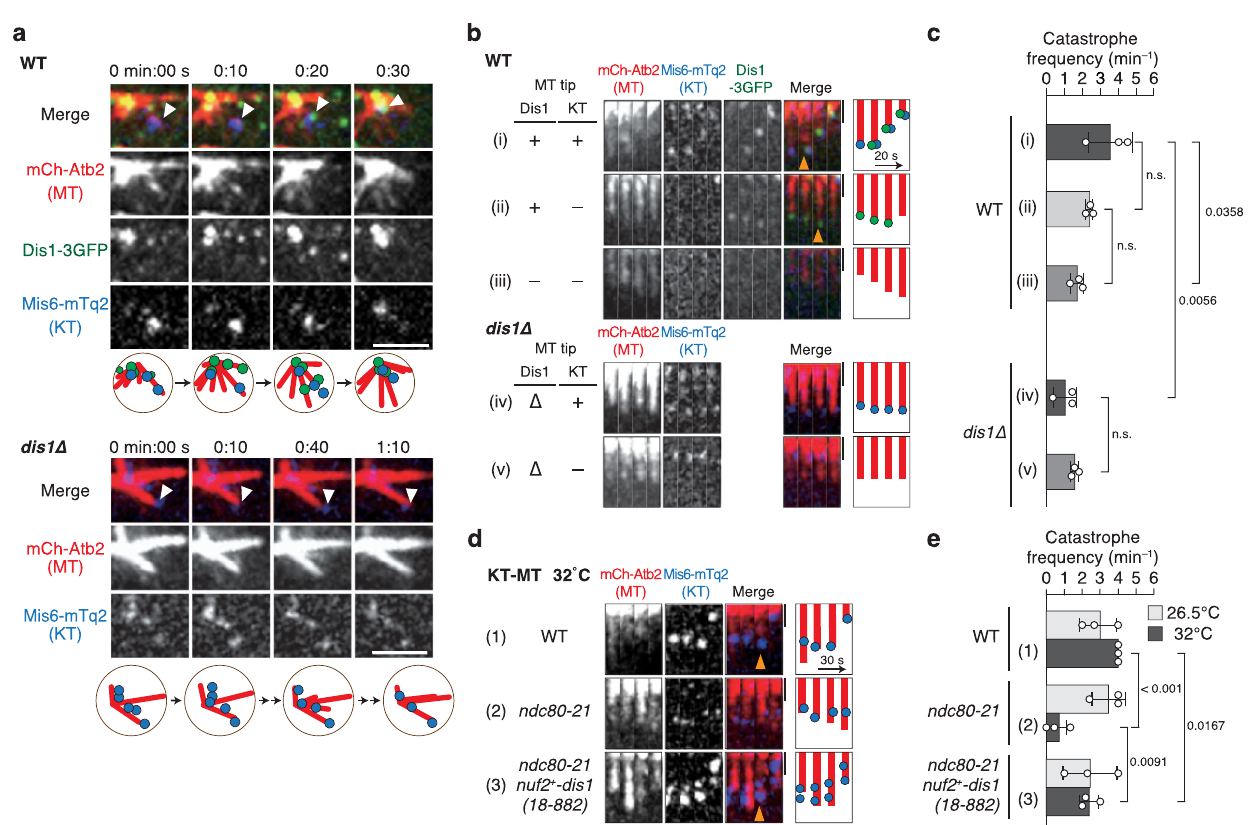
Fig. 2 Dis1 induces microtubule catastrophe at the onset of meiosis I. a Time-lapse images of zygotic nuclei at the onset of meiosis I in wild-type (WT) and dis1 Δ mutant cells at room temperature. Dis1-3GFP (green) co-localises with kinetochores (KT; labelled with Mis6-mTurquoise2, blue) at microtubule tips (MT; mCherry-Atb2, red). The kinetochore-bound microtubule tip (arrowhead) started shortening at 0:20. Schematics are shown at the bottom. In dis1 Δ , microtubules attached a kinetochore (arrowhead) but were not shortened. Scale bar, 2 µ m. b Representative kymographs of microtubules classi fi ed by the state of the tips, shown with schematics. In WT, (i) tips with both kinetochores and Dis1; (ii) tips without kinetochores but with Dis1; (iii) tips without kinetochores or Dis1. In dis1 Δ , with (iv) and without (v) kinetochores. The microtubules in (iv) are also shown in ( a ). Orange arrowheads represent microtubule catastrophes. Scale bar, 1 µ m. c The catastrophe frequency for each category in ( b ); n = 3 (i), 3 (ii), 3 (iii), 3 (iv), 3 (v) experiments. d Representative kymographs for kinetochore-microtubules in (1) WT, (2) ndc80-21 and (3) ndc80-21 nuf2 + -dis1(18-882) cells at the onset of meiosis I at 32 °C. Orange arrowheads represent microtubule catastrophe. Scale bar, 1 µ m. e The catastrophe frequency for each state is shown in ( d ); n = 3 experiments for each sample. Bullets indicate technical replicates, and error bars indicate SD. The statistical signi fi cance of the difference was determined using one-way ANOVA followed by the Tukey – Kramer method. P values are shown; n.s. not signi fi